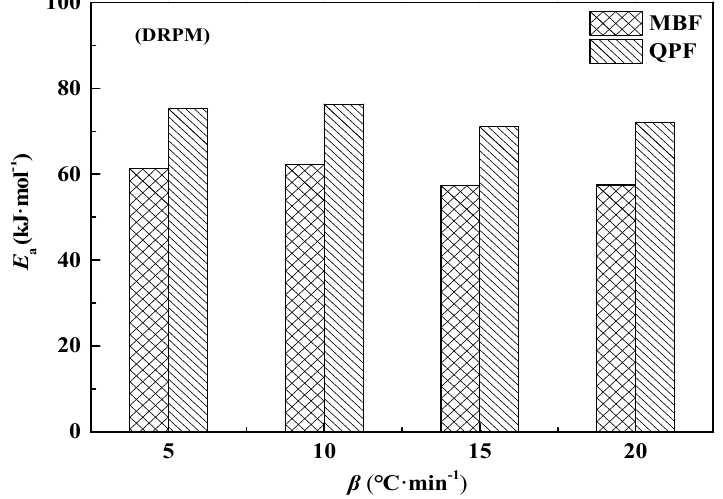
Figure 9. Comparison the apparent activation energy of MBF and QPF calculated by DRPM.